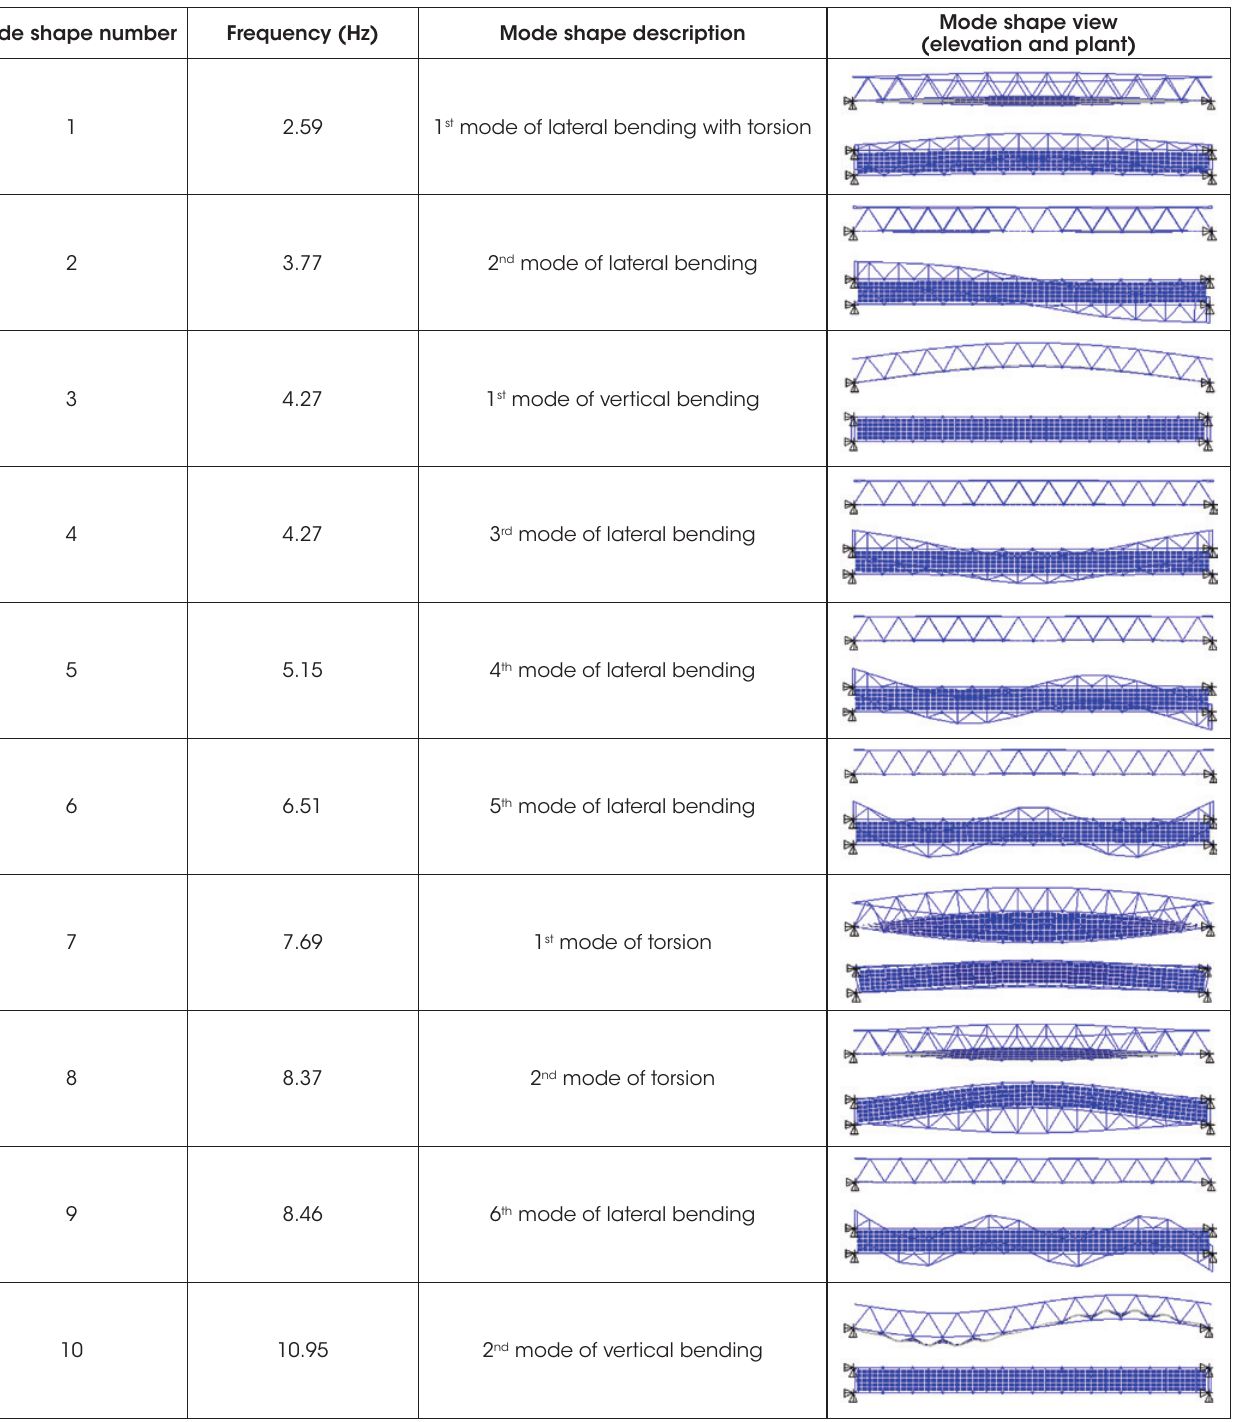
Frequencies and mode